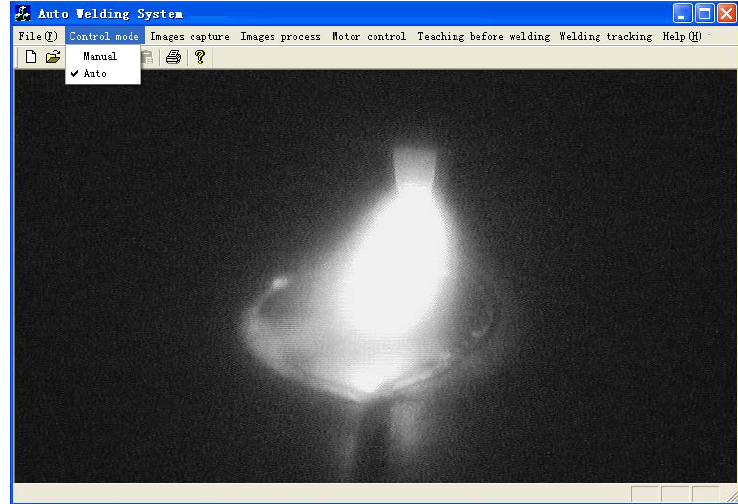
Fig. 3 Software of welding experimental